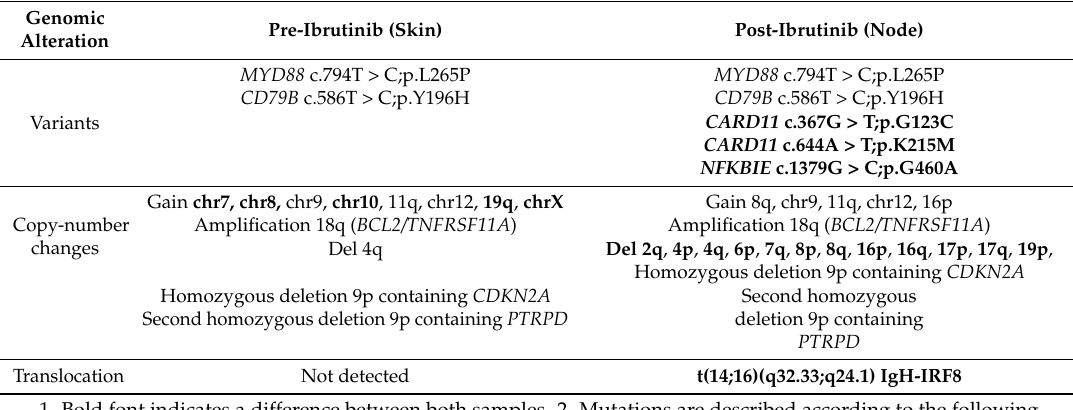
Table 1. Genomic alterations pre- and